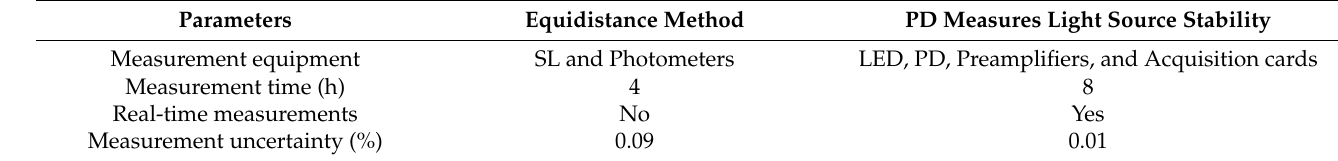
Table 5. Comparison of light source stability measurement